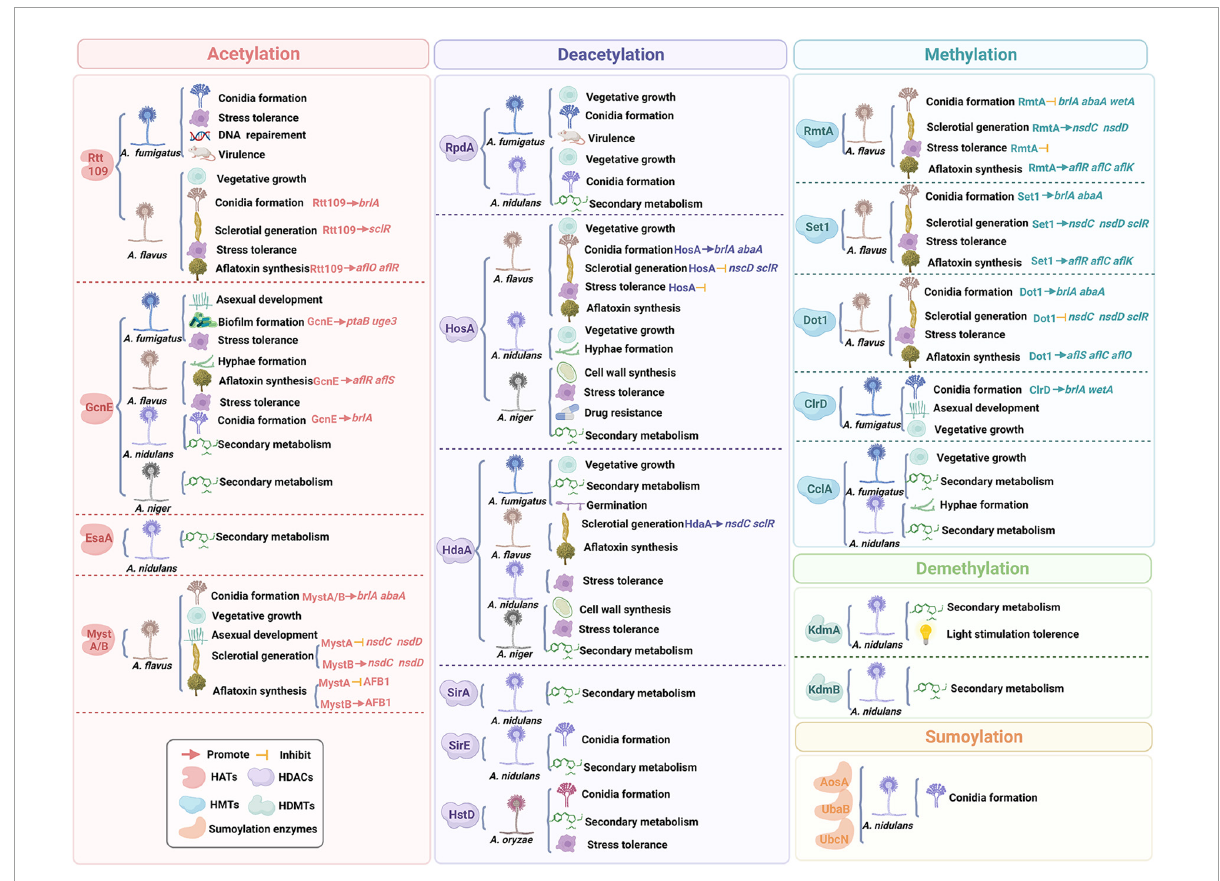
FIGURE2 A schematic representation of the relationship between histone post-translational modifications and fungal growth and